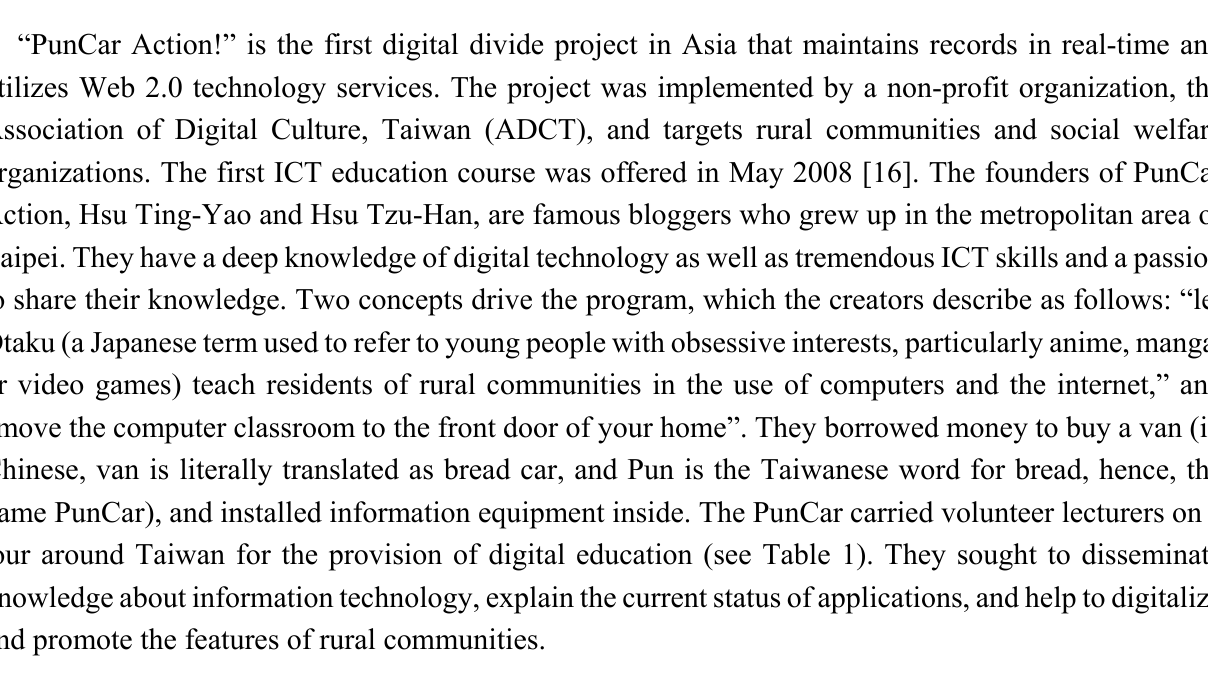
Table 1. PunCar Action tour record (up to the end of